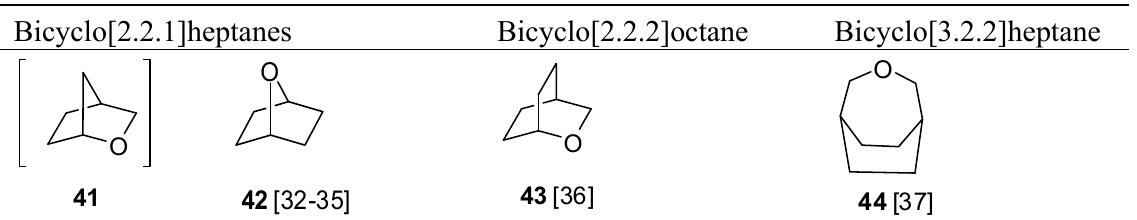
Table 5. Bicyclic ether monomers 41–44